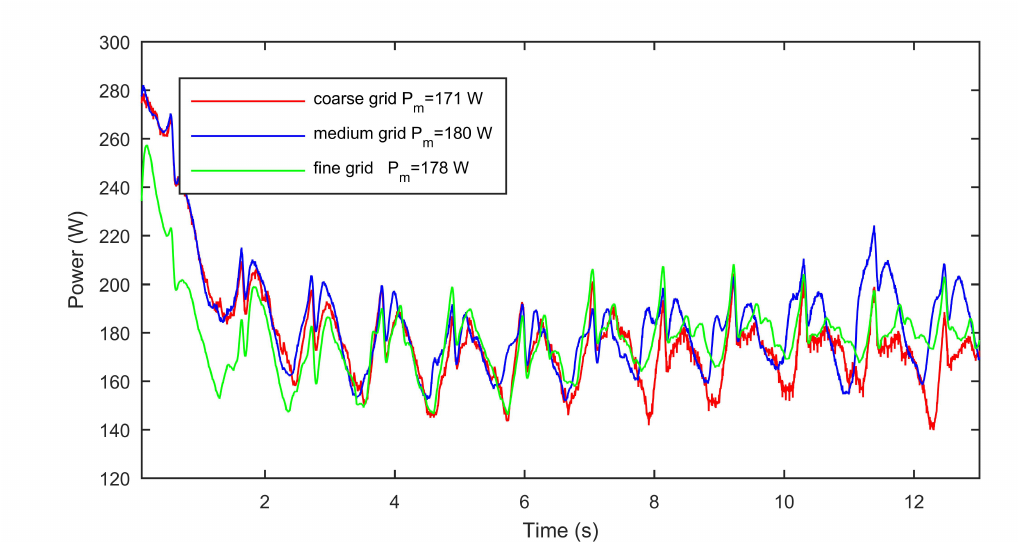
Figure 10. Power evolution for operating point at Q = 97.8 L/s, for three grids with different densities (medium, coarse and